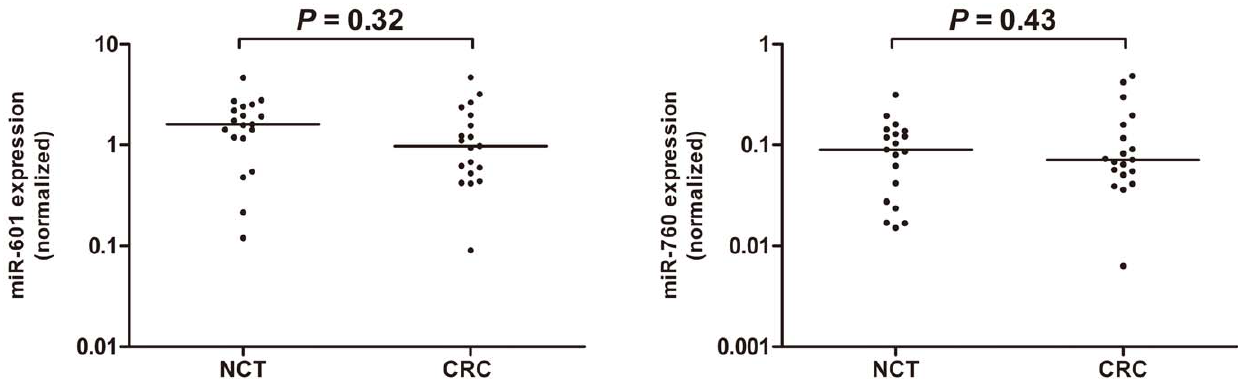
Figure 4. MiR-601 and miR-760 expression in CRC tissues. No significant differences about the miR-601(A) and miR-760(B) concentrations were found between CRC tissues and paired non-cancerous tissues (NCT) (n=19). Expression levels of the miRNAs were normalized to RNU6B. The line represents the median value. Mann-Whitney U test was used to determine statistical significance.